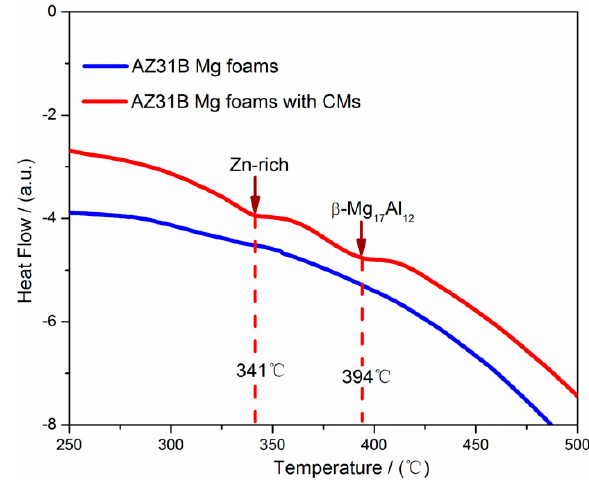
Figure 11. Differential scanning calorimeter (DSC) results of AZ31B foams with and without CMs.